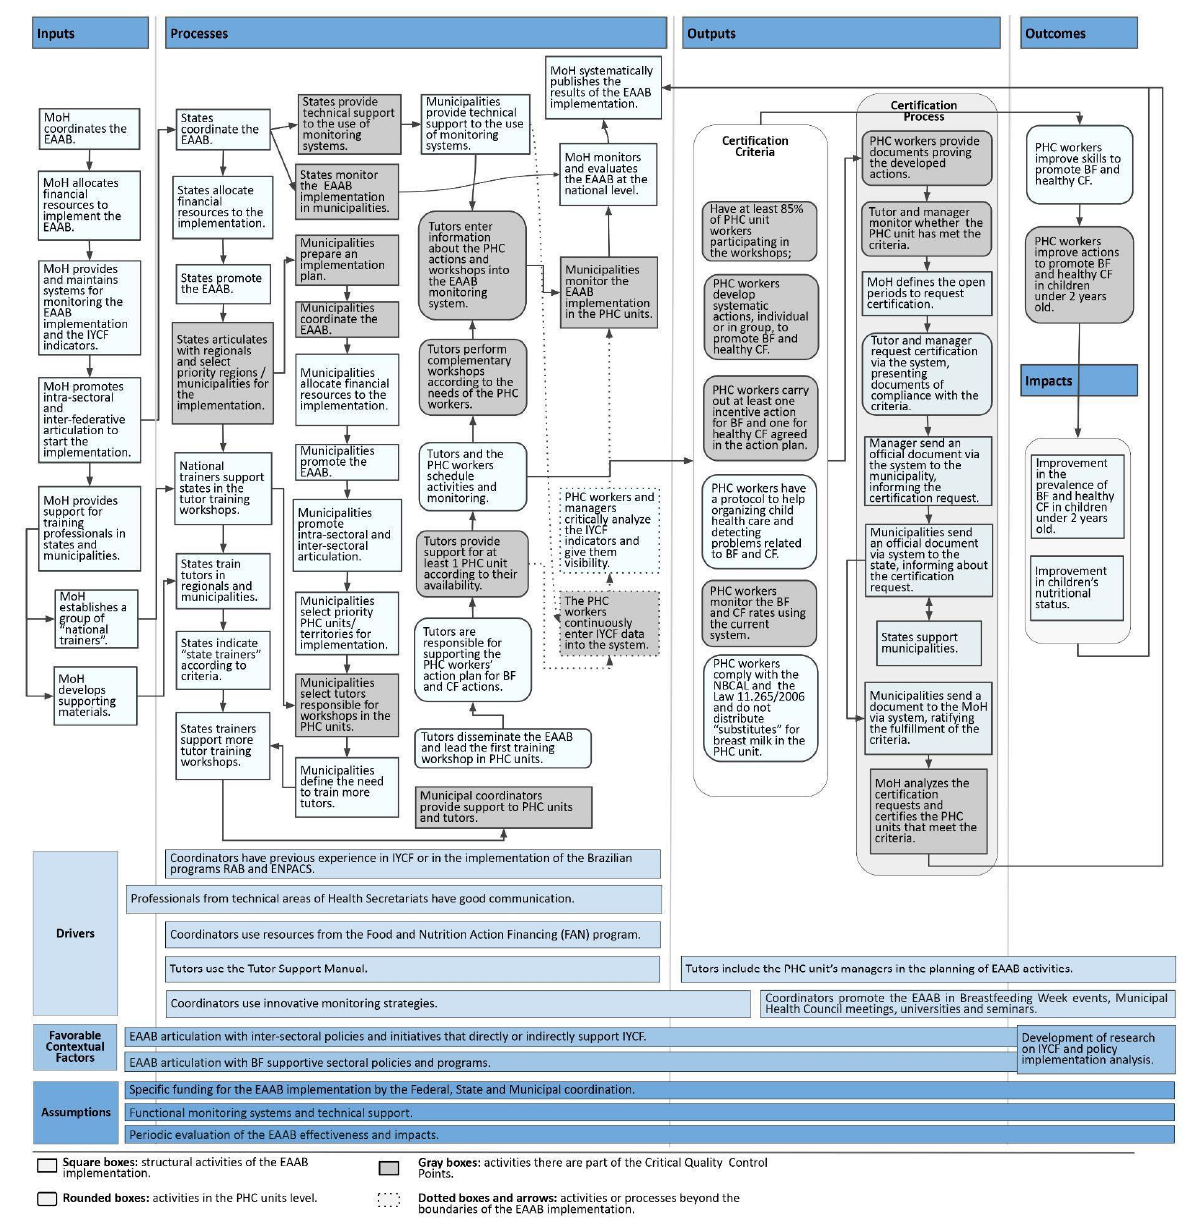
Figure 2. Revised PIP diagram of the implementation of the EAAB. Source: Developed by the authors with data obtained from document review and interviews with key informants. Notes: BF (breastfeeding); CF (complementary feeding); EAAB (Brazilian Breastfeeding and Complementary Feeding Strategy (Estratégia Amamenta e Alimenta Brasil)); ENPACS (National Strategy for Promotion of Complementary Healthy Eating (Estratégia Nacional para Alimentação Complementar Saudável)); IYCF (Infant and Young Child Feeding); MoH (Ministry of Health); NBCAL (Brazilian Norm for the Commercialization of Food for Infants and Young Children, Pacifiers, and Baby Bottles (Norma Brasileira de Comercialização de Alimentos para Lactentes e Crianças de Primeira Infância, Bicos, Chupetas e Mamadeiras)); PHC (Primary Health Care); RAB (Brazilian Breastfeeding Network (Rede Amamenta Brasil)).